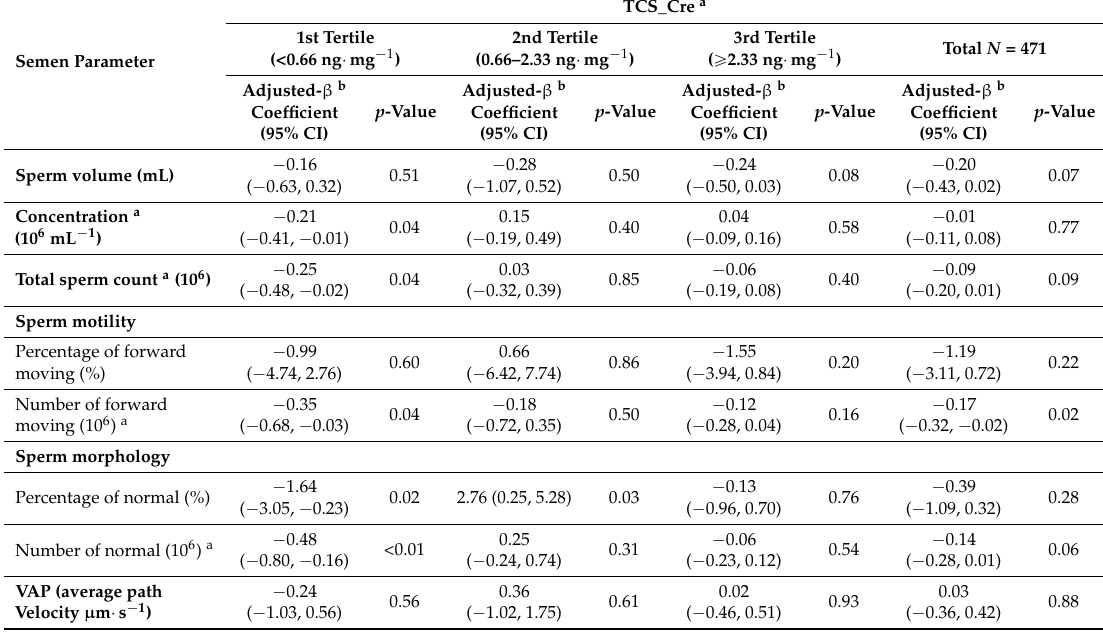
Table 3. Associations between semen parameters and urinary TCS level corrected by creatinine concentration (TCS_Cre) in each TCS_Cre tertile